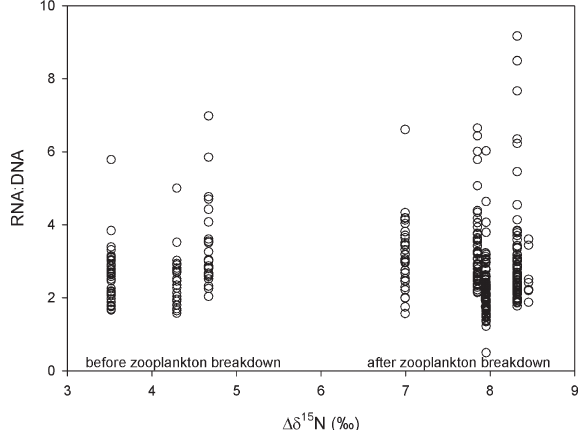
F IG . 9. – Relationship between the weekly mean Δδ 15 N of the larval dab and the corresponding RNA:DNA ratio.